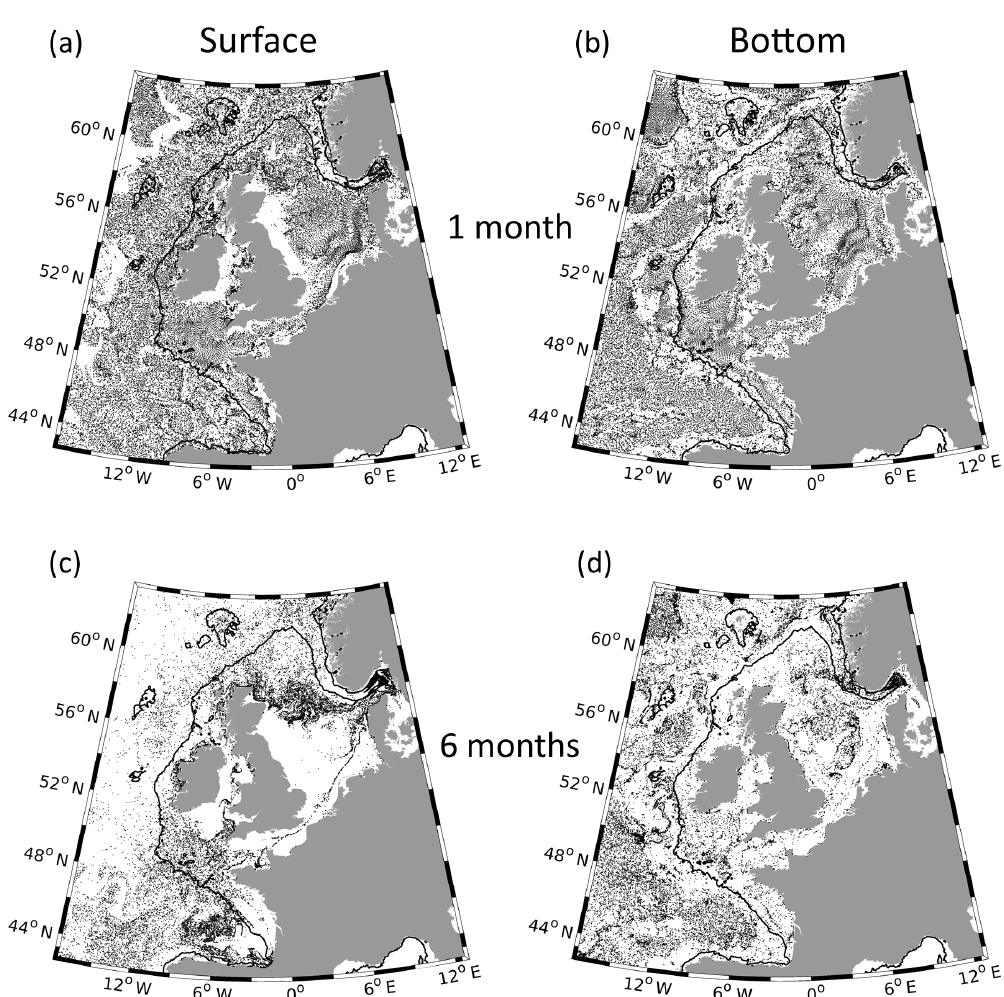
Figure 4. Particle positions after (a, b) 1 month and (c, d) 6 months released on 1 January 2015 at (a, c) the surface and (b, d) bottom in the control run (CR, no. 1; see Table